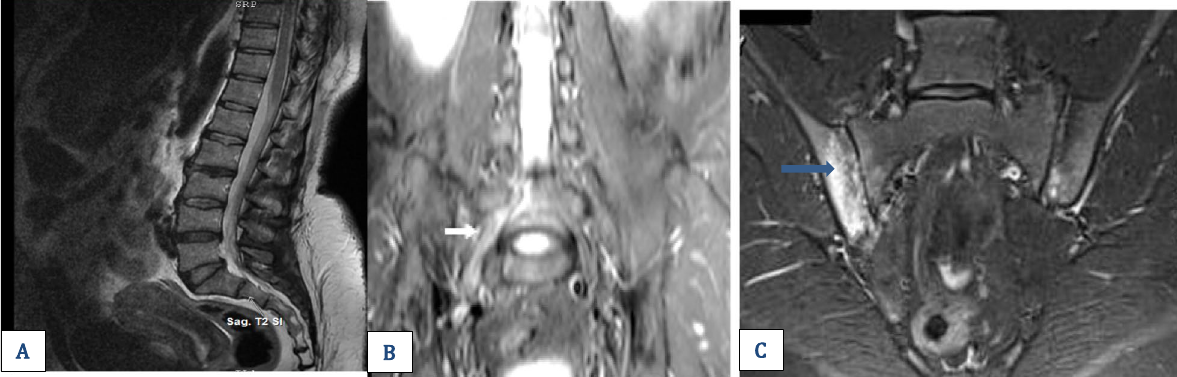
Fig. 4 A 45‑year‑old female patient (a known case of seronegative arthropathy), presented clinically with severe right sciatic pain referred to the right buttock and thigh with numbness and weakness. Electrophysiological studies showed prolonged F wave latency, raising test. Sagittal LS MRI shows no significant disk lesions ( A ). Pelvic MRN shows thickened and high signals in the right sciatic nerve with bilateral sacro‑iliitis, more on the right side (Arrows in B and C )